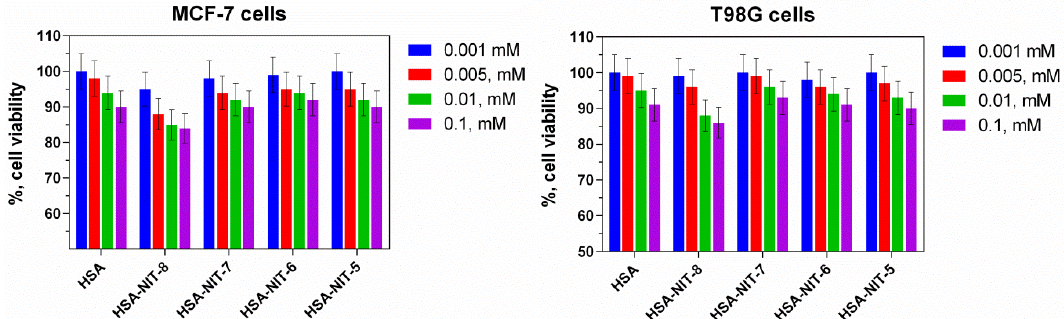
Figure 3. Effects of HSA-NIT conjugates on the viabilities of MCF-7 and T98G cell lines. Cell viability was normalized using cells treated with PBS buffer as a 100% viability control. There is no significant difference between HSA and any of the conjugates.